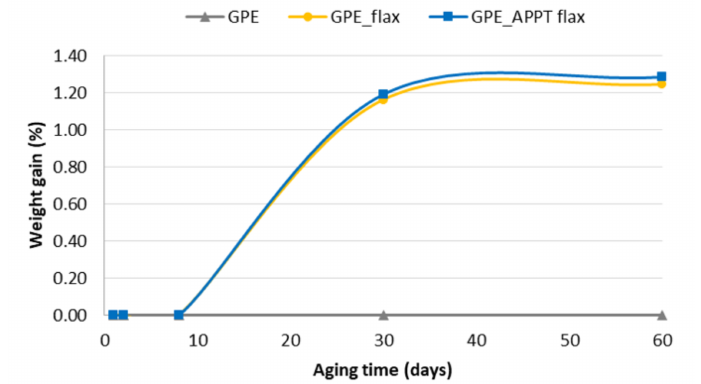
Figure 8. Weight gain of APPT treated and untreated GPE